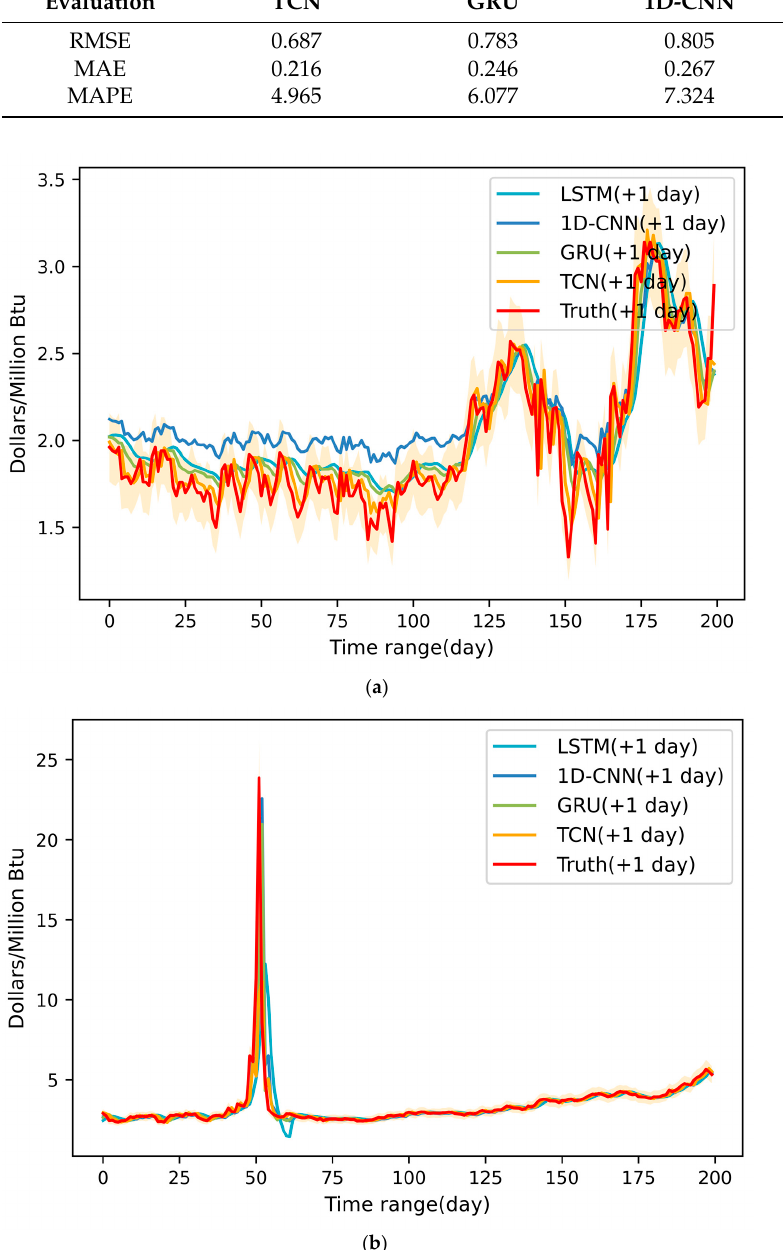
Figure 8. Comparison of the tracking curve of the forecasting performance on the first working day in the future, ( a ) plateau, ( b )volatility period.